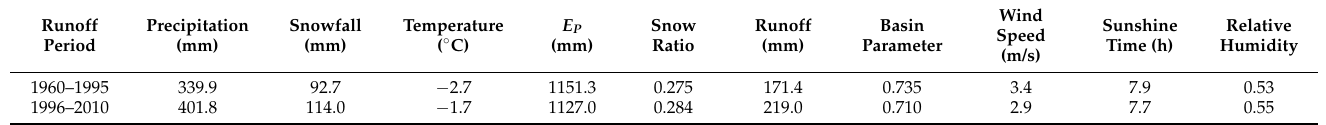
Figure 2. The trend in hydro-meteorological variables: ( a ) annual precipitation, ( b ) snowfall, ( c ) E P , ( d ) runoff, ( e ) average air temperature, and ( f ) snow ratio during the period of 1960–2010. The dotted line is the linear trend for this period. Table 2. The value of annual precipitation, snowfall, average air temperature, snow ratio, E P , runoff, wind speed at 10 m, sunshine time, and relative humidity during the base period (1960–1995) and change period